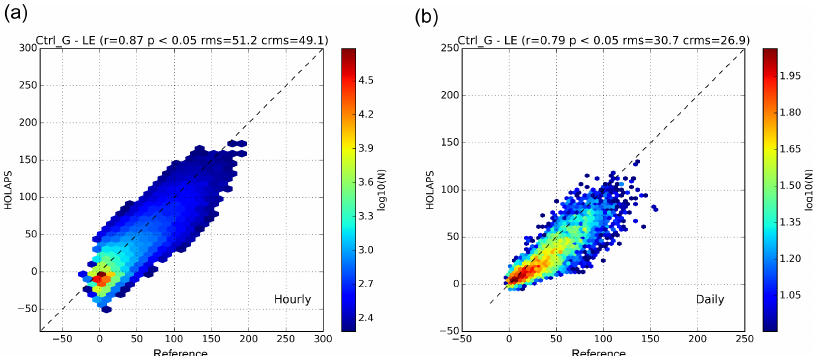
Figure 7. Comparison of HOLAPS latent heat flux for (a) hourly and (b) daily timescale for the CTRL experiment using results from all stations and years. Units in Wm − 2